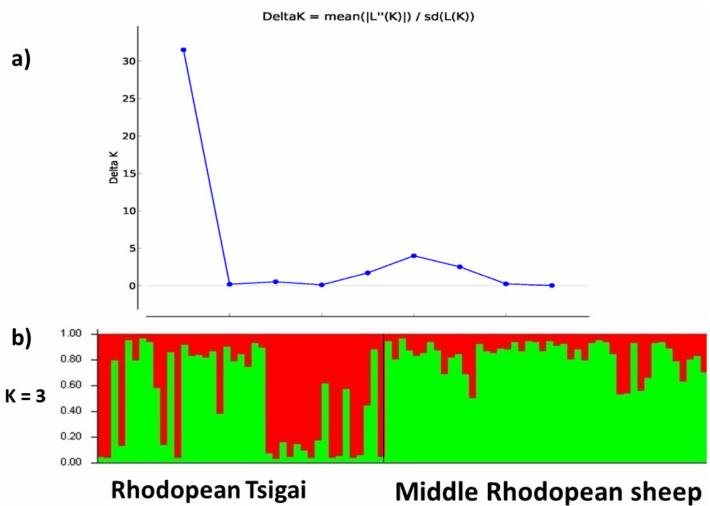
Figure 2. Genetic structure of two Bulgarian sheep breeds based on STR marker data under an assumption of K = 2–12 using the STRUCTURE 2.3.4 program. ( a ) Estimation of the most probable K, following the delta K method of Evanno et al. [39]. ( b ) Each individual is represented by a vertical bar displaying membership coefficients for each genetic cluster. Populations are separated by black lines. Graphics were obtained with STRUCTURE HARVESTER and the DISTRUCT